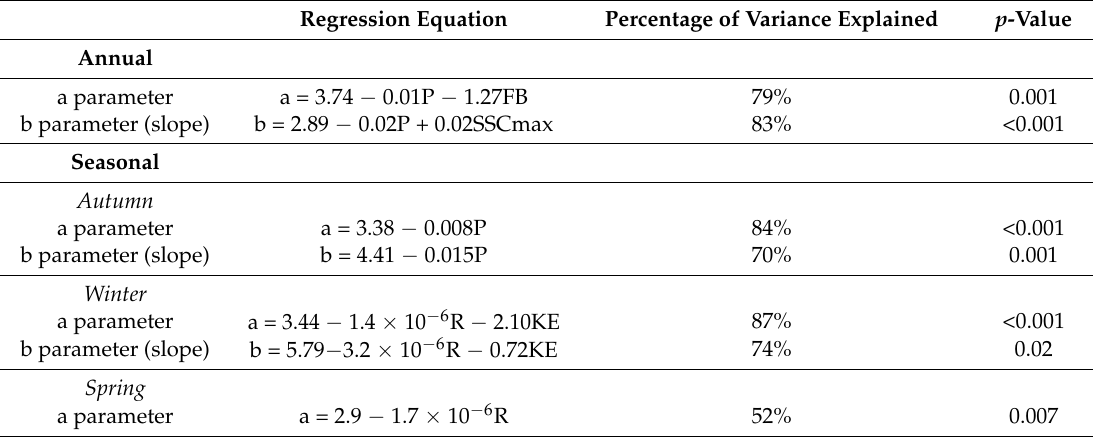
Table 2. Derived equation for the SS-Q relationship parameters applying the stepwise multiple regression technique and variance